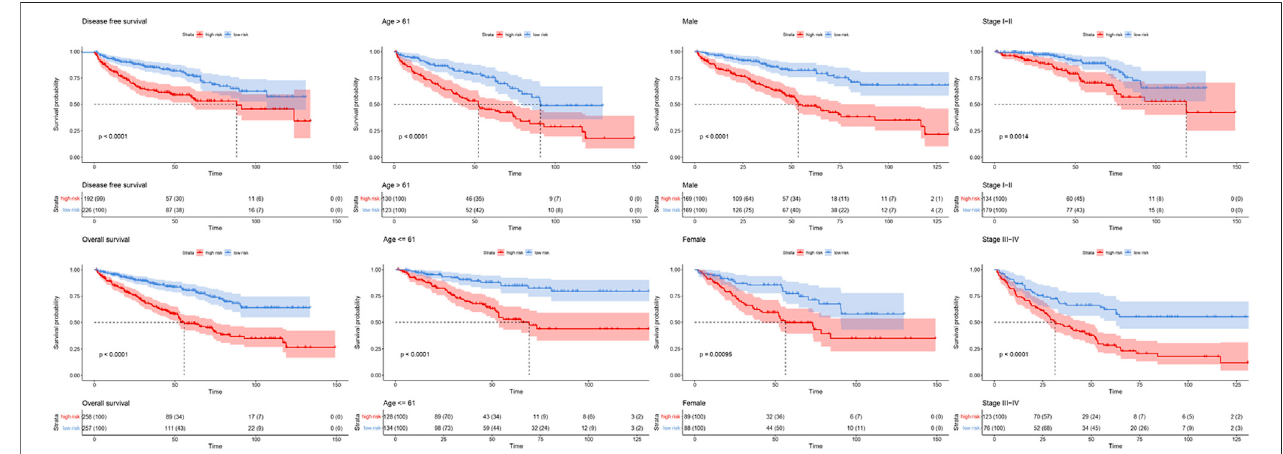
FIGURE 10 | Survival curve of high and low risk groups in different cohorts sorted by clinical signatures. Red line represented patients in high risk group, blue line represented patients in low risk